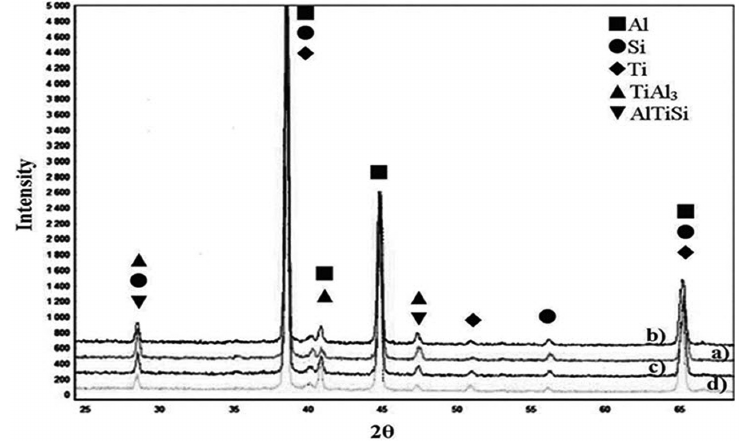
Figure 3. XRD analysis of A356+6% Ti AMCs synthesized at the temperature of 550 °C for 1 (a), 4 (b), 8 (c) and 16 h